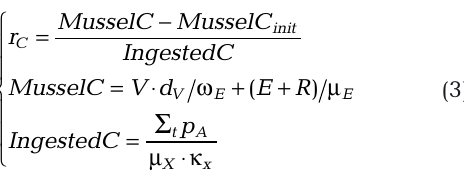
Table 2. Summary of scenarios of mussel farming